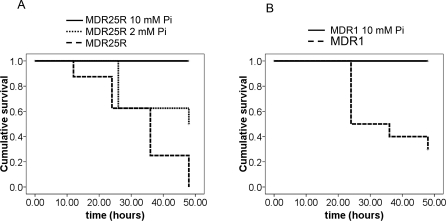
Intestinal Phosphate Supplementation Prevents the Lethality of MDR Strains in MiceSeven-week-old male C57BL6 mice were given either water (no phosphate supplementation), or 2 mM PBS solution (2 mM phosphate supplementation), or 10 mM PBS solution (10 mM phosphate supplementation) for 36 hours prior to hepatectomy. P. aeruginosa MDR25 was grown overnight in Pseudomonas broth (PB) containing Gm, 50 μg/ml, cells were collected by centrifugation, resuspended in either water containing 10% glycerol (group 1, n = 8), or 2 mM PBS (group 2, n = 8) or 10 mM PBS (group 3, n = 5) to final OD600 nm 0.2, and 200 μl of bacterial solutions were injected into cecum immediately after hepatectomy. The abdomen was closed and mice were allowed to drink either water (group 1) or 2 mM PBS (group 2) or 10 mM PBS (group 3) and followed for mortality. Data were analyzed using Kaplan-Maier survival curves with SPSS software and significance tested by Log-rank (Mantel-Cox) p = 0.004. Reiterative experiments were performed with the clinical isolate MDR1 with the exception that only 10 mM of phosphate supplementation was tested (n = 10/group, p = 0.001).